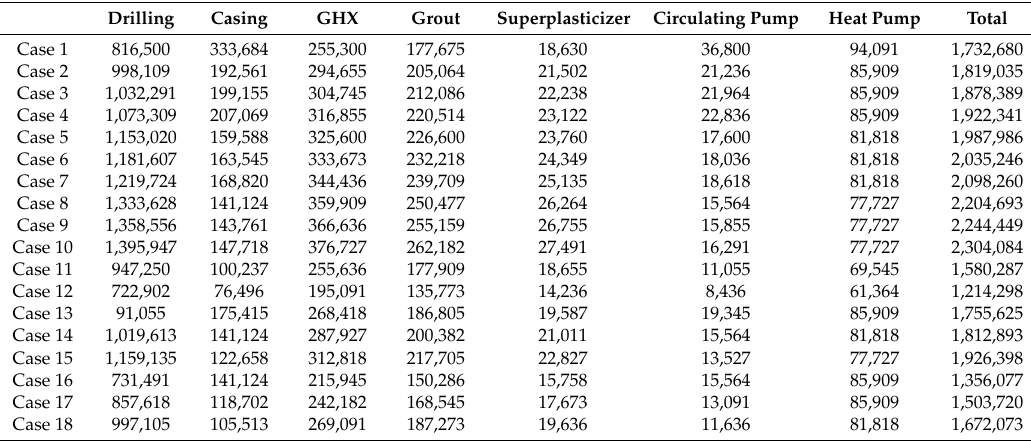
Table 8 represents the initial investment for each case. Initial investment was calculated by adding labor cost to the material cost corresponding to each number of drilled boreholes presented in Table 7. Table 8. Initial investment for each case (Unit: